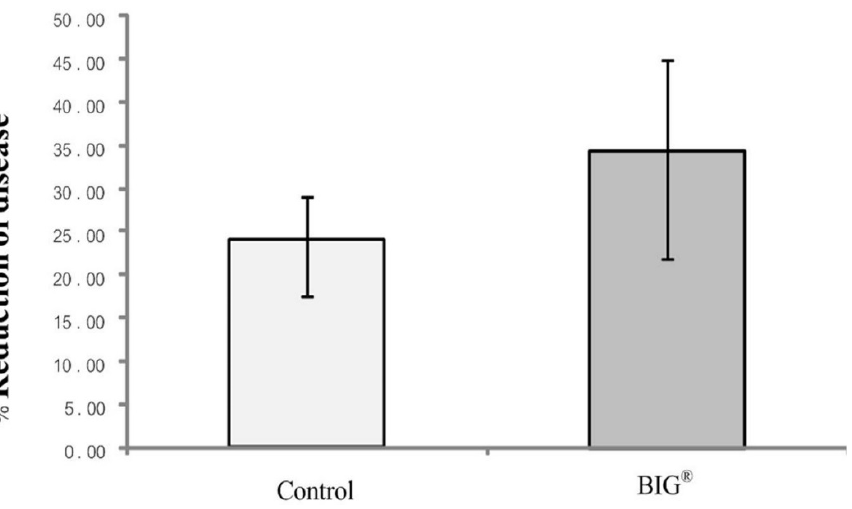
Figure 3. Effect of BIG ® on the reduction of rice BLB disease severity under greenhouse conditions.